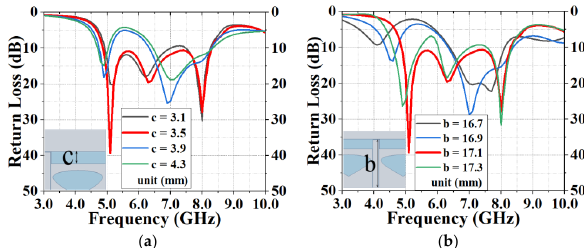
Figure 7. Improvement of the return loss by optimizing ( a ) transmission line length, b, and ( b ) T-slot width, c.